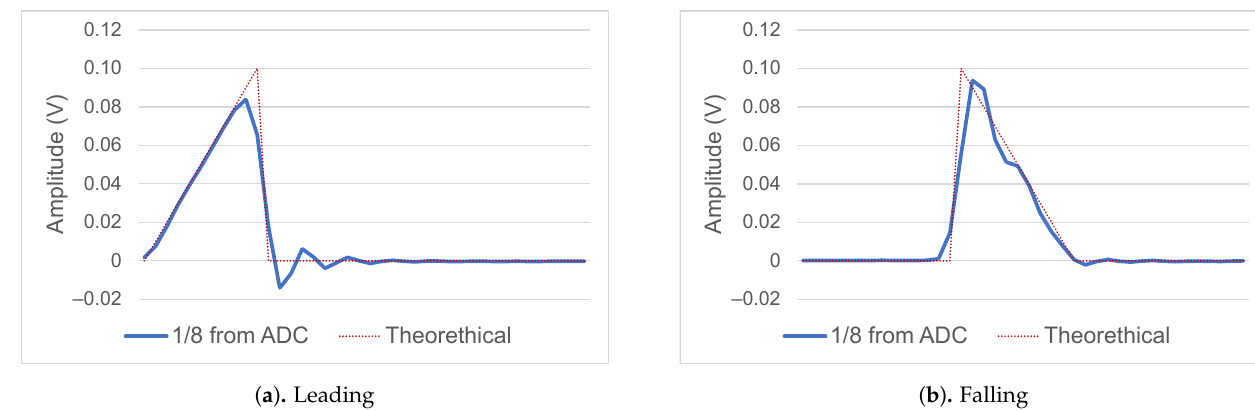
Figure 14. ADC sampled waveforms: ( a ) leading; and ( b ) falling.